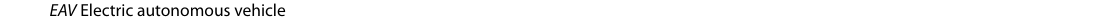
EAV Electric autonomous